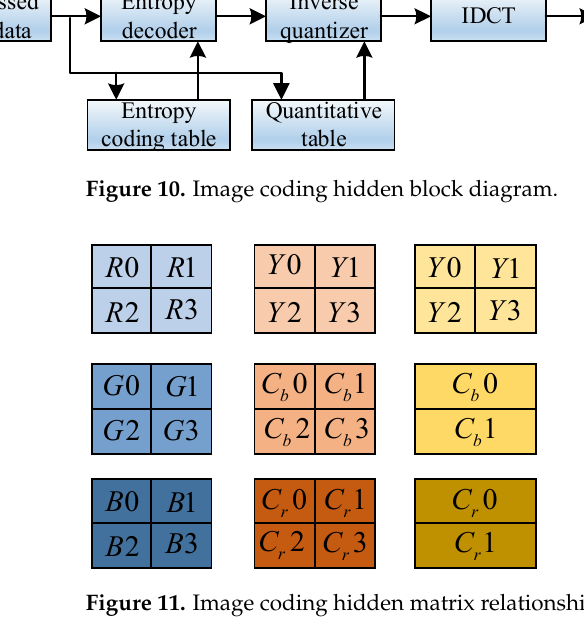
Table 9. Image coding hidden luminance